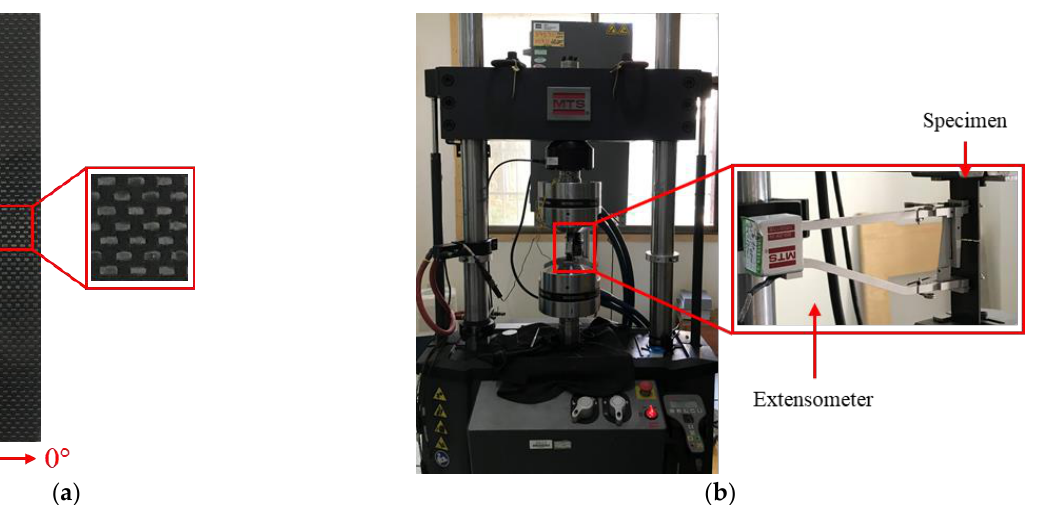
Figure 2. Specimens for tensile test. ( a ) Specimen and fiber orientation for the tensile test; ( b ) tensile test configuration.